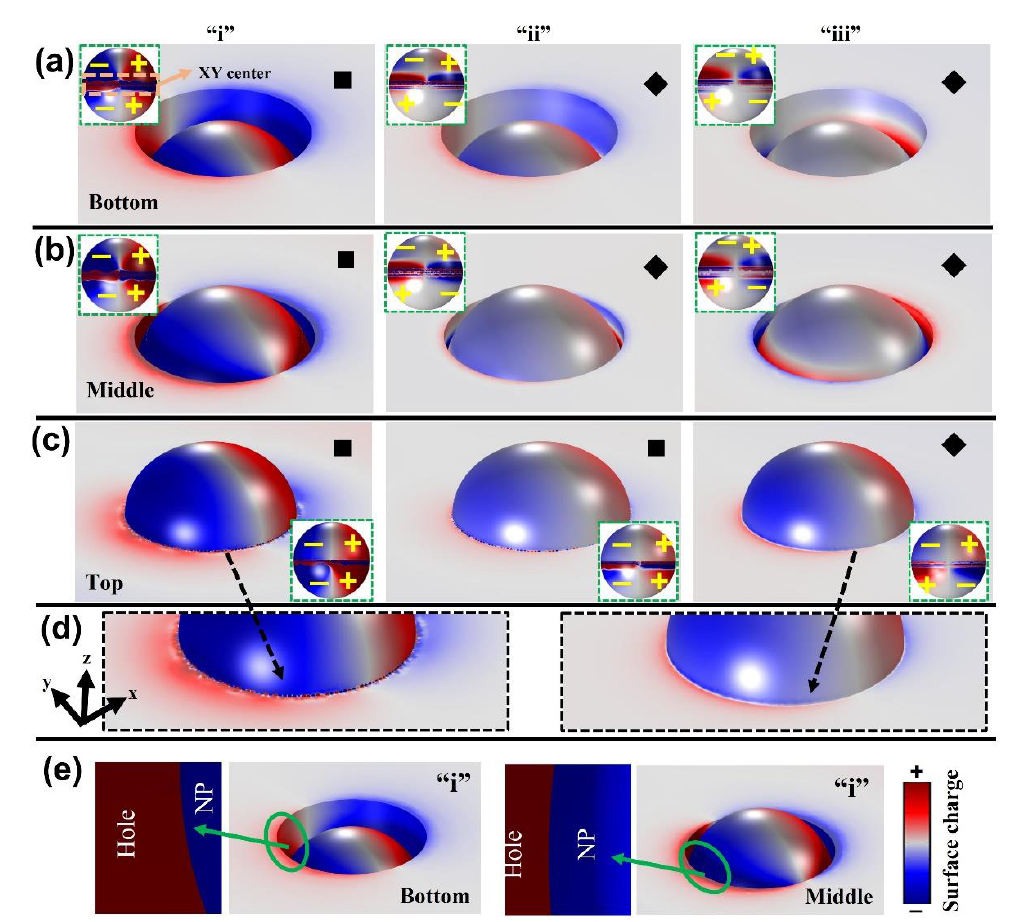
Figure 4. ( a – c ) 3DSCDM profiles extracted from integrated nanostructures from their respective resonance wavelength positions marked from “i” to “iii”. ( d ) Magnified surface charge density distributions near NP–hole interface for an integrated nanostructure with a NP positioned on the top (for resonance wavelength positions “i” and “iii”). ( e ) Magnified surface charge density distributions near NP-hole interface for integrated nanostructures when NP is positioned at bottom and middle (resonance wavelength position “i”).